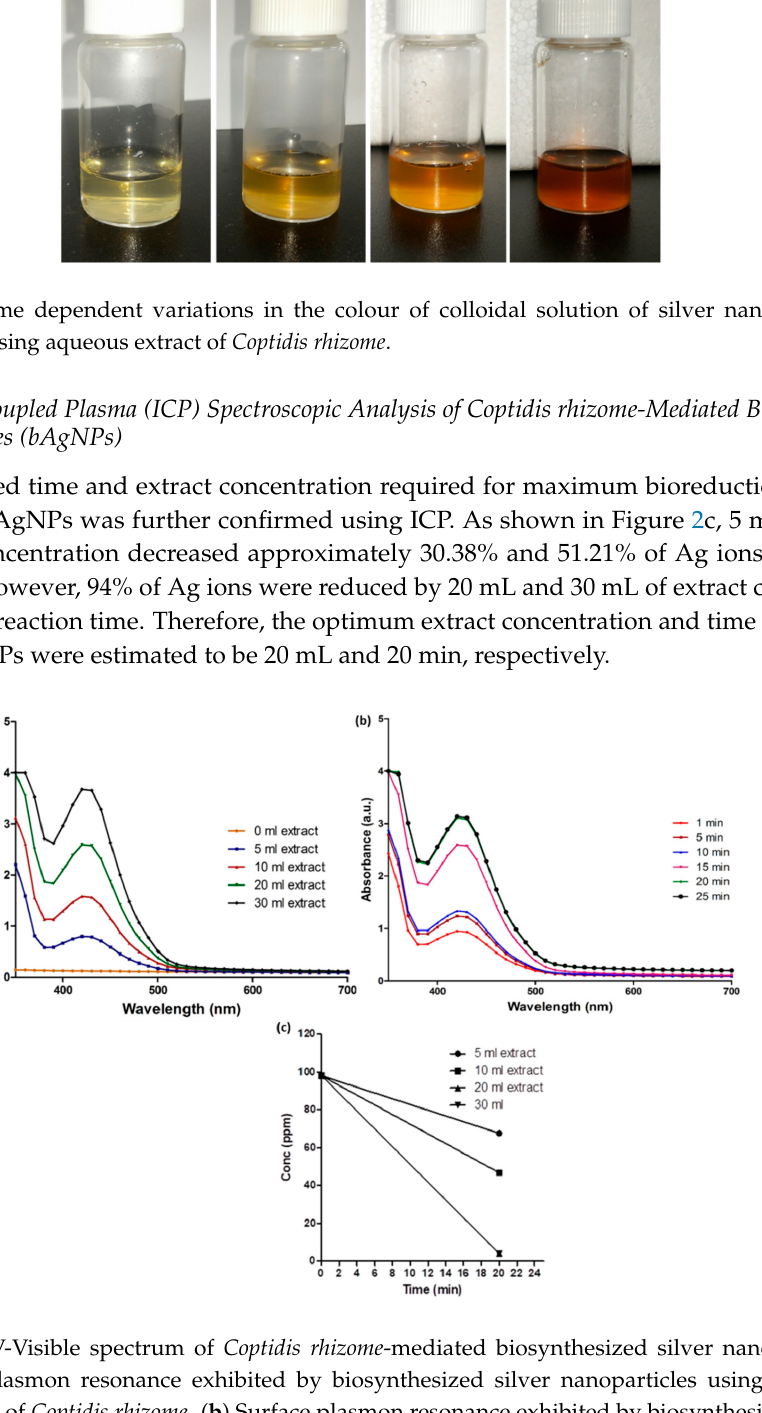
Figure 2. UV-Visible spectrum of Coptidis rhizome -mediated biosynthesized silver nanoparticles. ( a ) Surface plasmon resonance exhibited by biosynthesized silver nanoparticles using different concentration of Coptidis rhizome . ( b ) Surface plasmon resonance exhibited by biosynthesized silver nanoparticles at different time intervals. ( c ) Inductively coupled plasma graph of silver ions converted into zero valent form at different concentrations of Coptidis rhizome